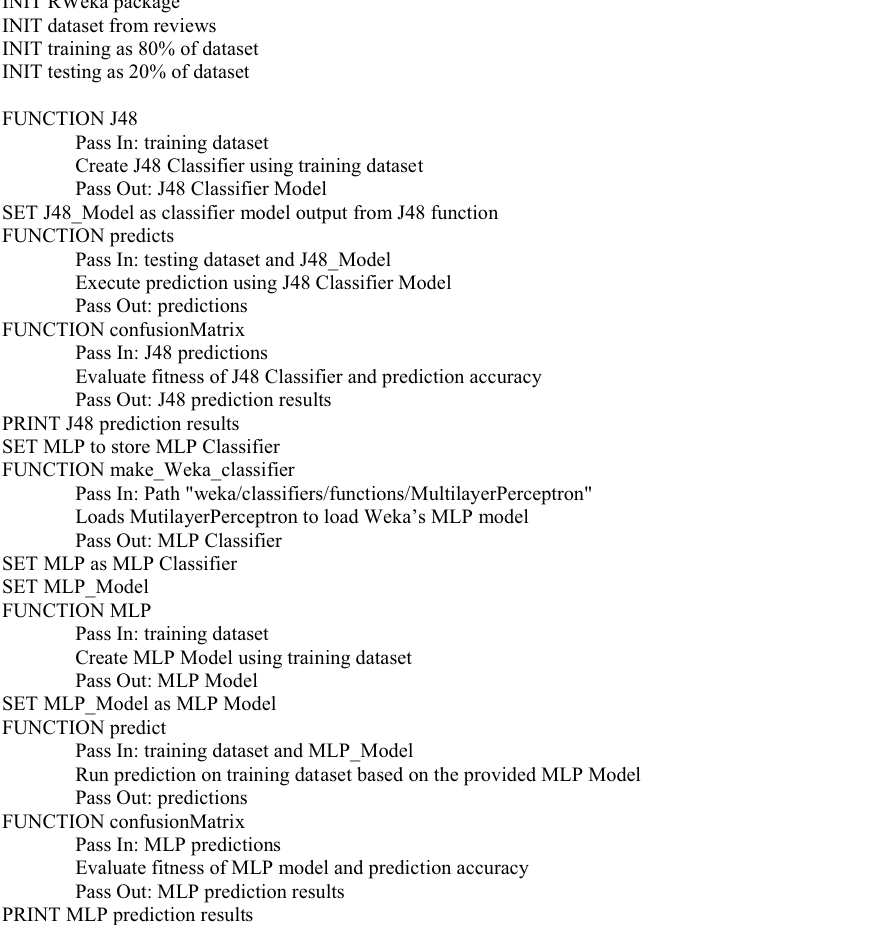
Table 11 Pseudocode to create training and testing dataset using J48 Classifier and MLP Classifier INIT RWeka package INIT dataset from